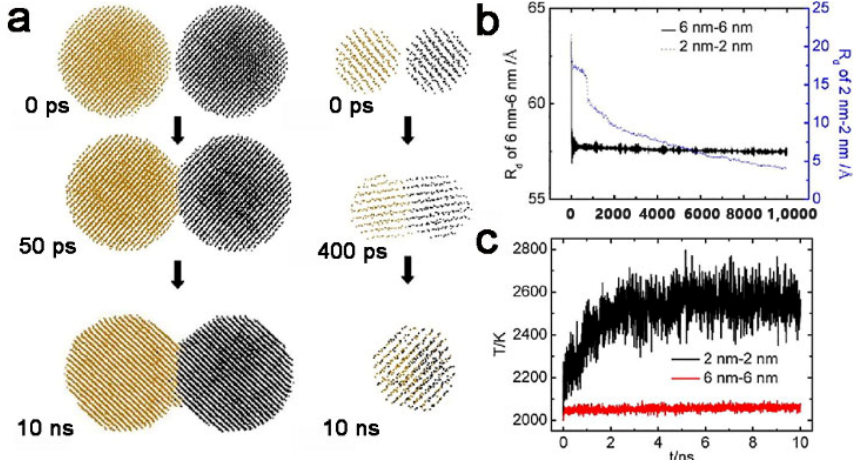
Figure 4. ( a ) Simulated structures of two solid nanoparticles during coalescence. Left column: two 6 nm nanoparticles; right column: two 2 nm nanoparticles. ( b ) The evolution of R d diameters at 2000 K for solid-solid coalescence model. ( c ) The evolution of temperature T during solidsolid coalescence process. Reproduced with permission [64]. Copyright 2017, Elsevier B.V.